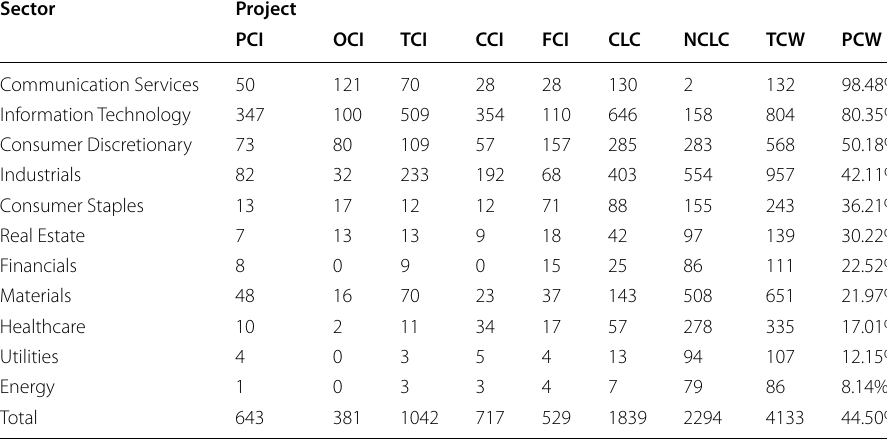
Table 2 CCEI component stocks by